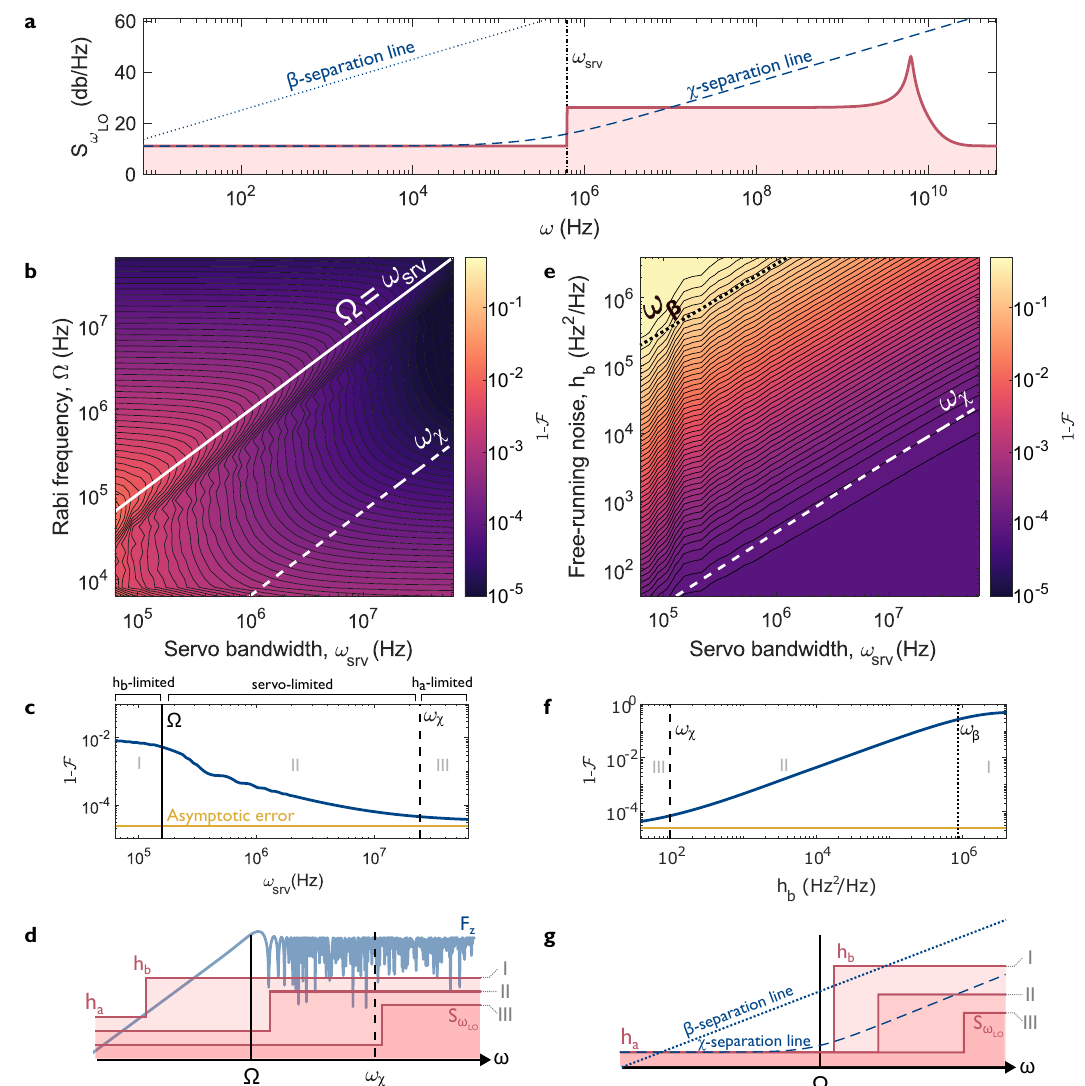
Fig. 3 The in fi delity parameter space for a servoed diode laser with a Γ FWHM = 1 Hz narrowed linewidth ( h a = 4 π × 1Hz). a The frequency noise PSD of a LO generated from a servoed diode laser. Within the servo loop, the noise amplitude takes the value of h a . Above the servo bandwidth, ω srv , the LO takes on the free-running laser noise including a relaxation oscillation peak of 20dB at 2 π × 1GHz. b The in fi delity landscape as the Rabi frequency and servo bandwidth are varied, demonstrating three main regions (detailed in text). The h b -limited region is separated by Ω = ω srv (solid line) from the servo-limited region, with the χ -separation line (dashed) delineating the h a -limited region. c A 1D cross-section of ( b ) at Ω = π /2 × 10 5 Hz. d A diagrammatic representation of noise spectral densities in each of the three regions, with the π − pulse fi lter function (in arbitrary units) overlaid for comparison. e The in fi delity landscape as the above-servo noise amplitude, h b , and the servo bandwidth are varied for Ω = 2 π × 10kHz. The β -separation line (dotted), does not guarantee qubit coherence, while the χ -separation line (dashed) again bounds the h a -limited region. f A cross-section of ( e ) at ω srv = 300kHz. f A diagrammatic representation of the PSDs in each of the three regions with respect to the β - and χ -separation lines. The χ -separation line in Fourier space is given by Eq.